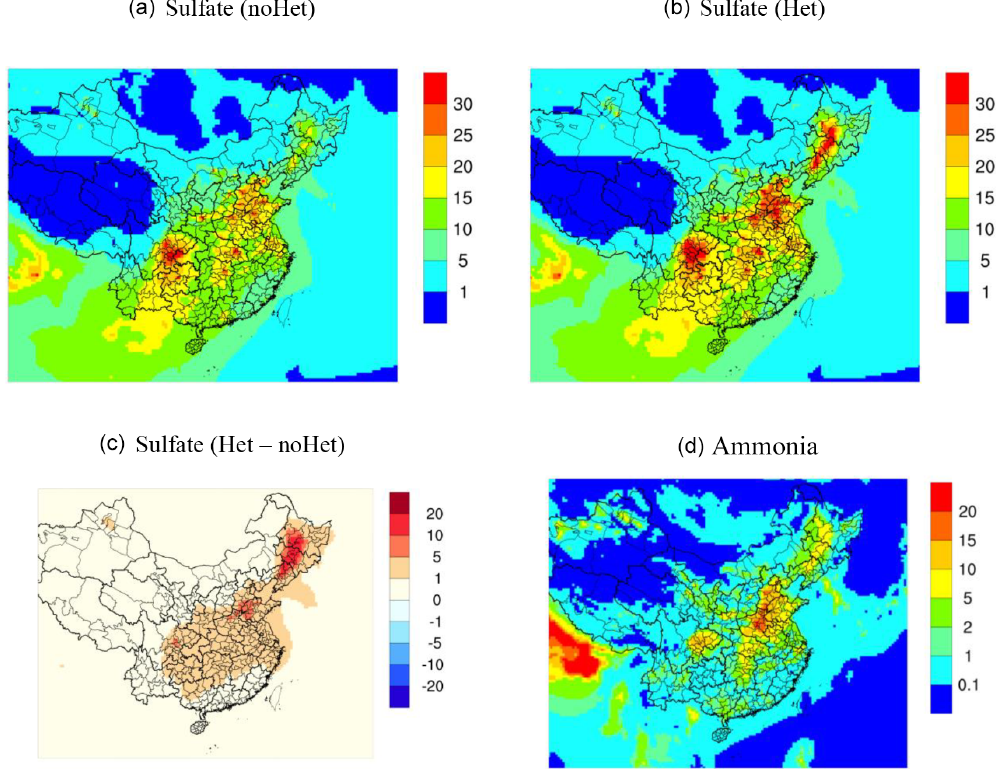
Figure 10. Spatial distribution of simulated monthly sulfate concentrations (µgm − 3 ) over the 36km domain for the base case scenario (a) , Het (b) and the differences between the two scenarios (c) and ammonia concentrations (µgm − 3 ; d